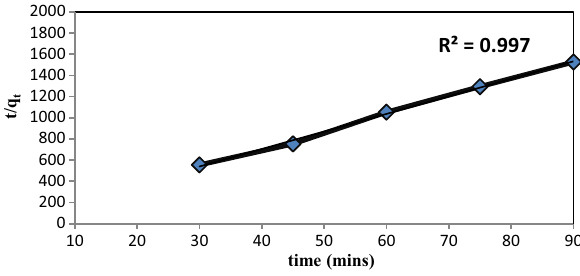
Fig. 6 Freundlich isotherm of HAp on arsenic of 0.3 mg/L at 120 rpm, temperature 30 °C and pH of 7